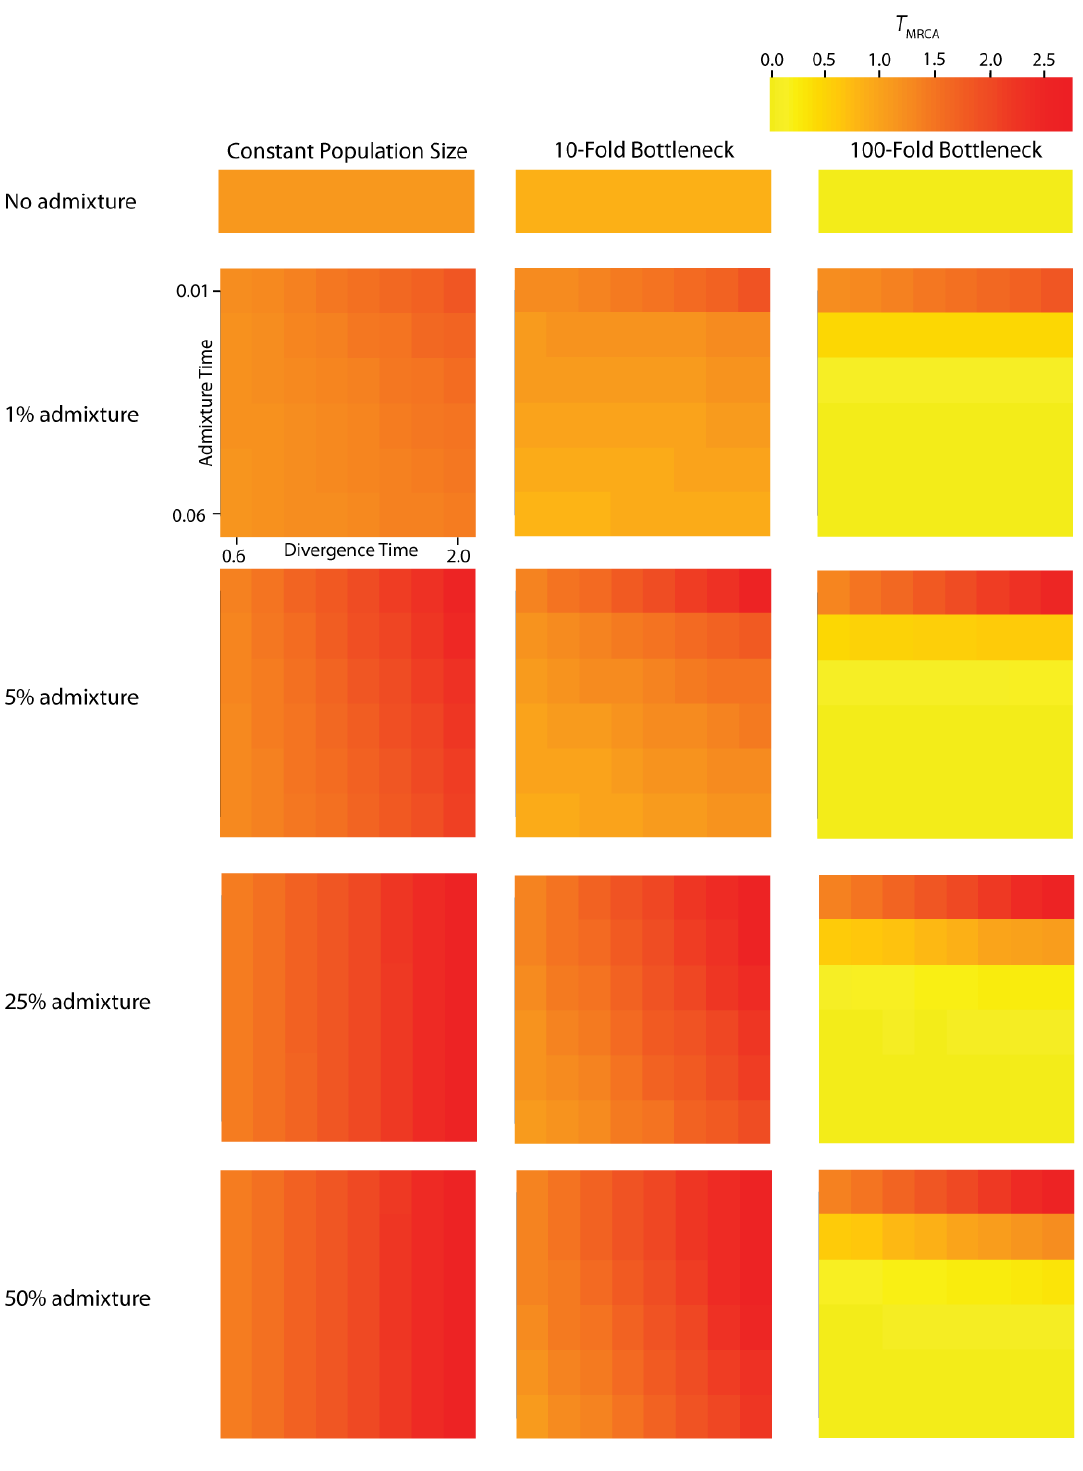
Figure 4. Simulated values for the height of genes trees, or T corresponds to a different magnitude of founder event in the colonizing population. Each row represents differing levels of admixture between the colonizing and endemic populations. Finally, within each panel, squares correspond to different combinations of population divergence time and admixture time in the IAA